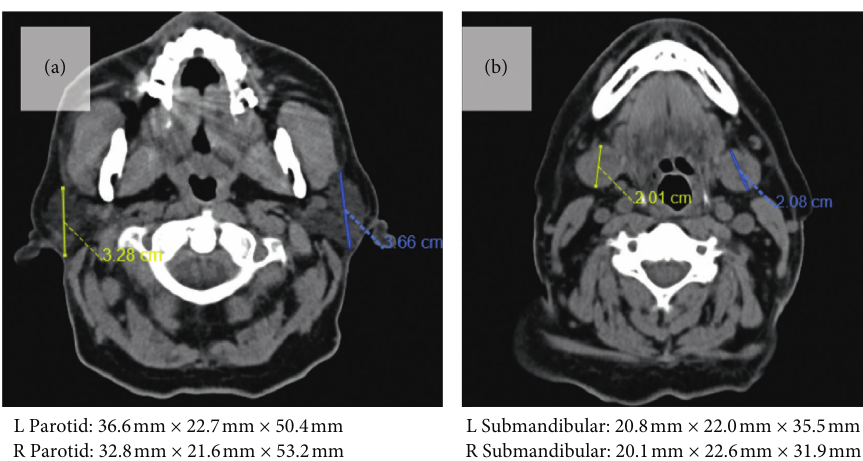
Figure 2: CT neck w/o contrast axial views demonstrating no enlargement of either the parotid gland (a) or submandibular gland